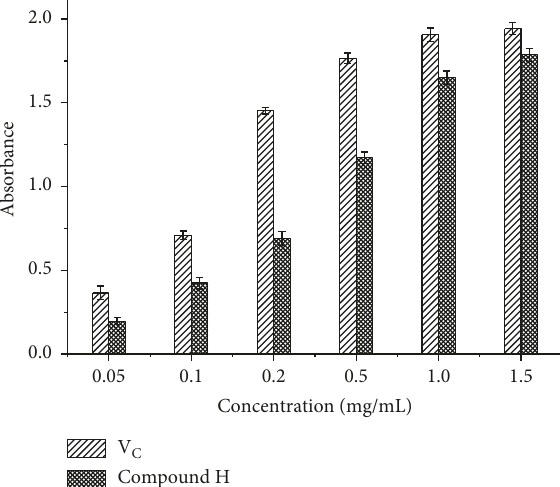
Figure 13: Reducing power of compound H and V C , and organic ex-